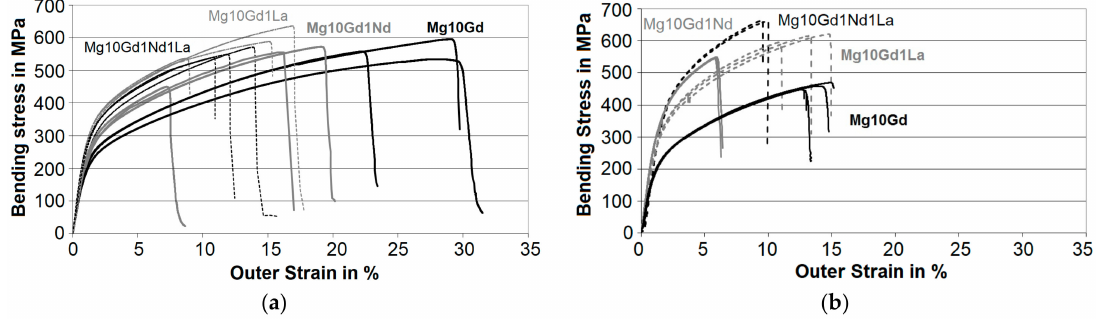
Figure 6. Influence of precipitation hardening on bending of Mg10Gd x Nd x La: bending stress-outer strain curves of ( a ) extruded and ( b ) T6-12 h.